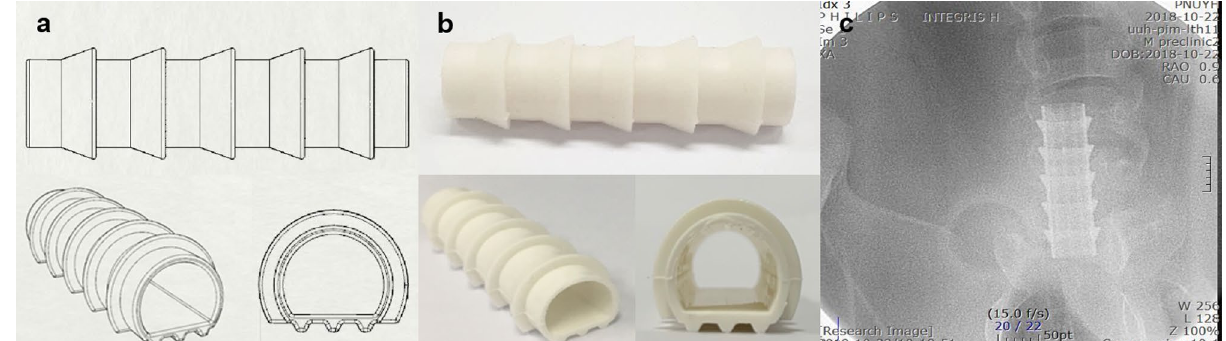
Figure 2. GINA stent, the silicone stent recently developed by the authors, has an anti-migration design, dynamic structure that enables the reduction of stent cross-sectional area, and radio-opacity. ( a ) Design of the GINA stent. ( b ) Actual GINA stent [outer diameter of 14 mm (OD14), ring diameter of 18 mm (RD18), and length of 55 mm (L55)]. ( c ) Radio-opacity of the GINA